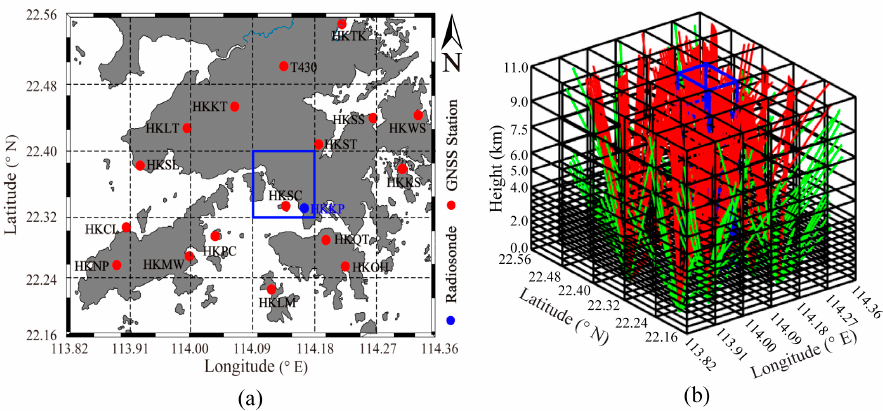
Figure 7. ( a ) Plane map of the Hong Kong area obtained by Mercator projection with 17 Global Navigation Satellite System (GNSS) reference stations (red dots) and radiosonde King’s Park Meteorological Station (HKKP) (blue dot) in Hong Kong; ( b ) 3-D distribution of GPS signals for the proposed tomography model. Red lines represent signals passing from the top boundary of the tomographic area, whereas green lines denote rays penetrating from the side face of the tomography region. The blue vertical columns represent the radiosonde (RS)-voxels where the radiosonde is located.